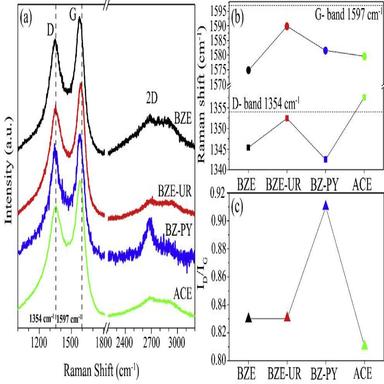
(a) Raman spectra of N-CFSs. The vertical lines indicate the characteristic values of D and G Raman shift in graphite. D and G graphite bands with values of 1354 and 1597 cm-1 , respectively. (b) Raman shift for D and G bands. (c) The ratio of the intensity of the D Raman peak and the G Raman peak (ID/IG). Fig. S5 and Table S5 show the deconvolution analysis of D and G bands. N-CFS, nitrogen-doped carbon fiber sponge; BZ-PY, pyridine-benzylamine; ACE, acetonitrile-ethanol; BZE-UR, BZE saturated with urea; B